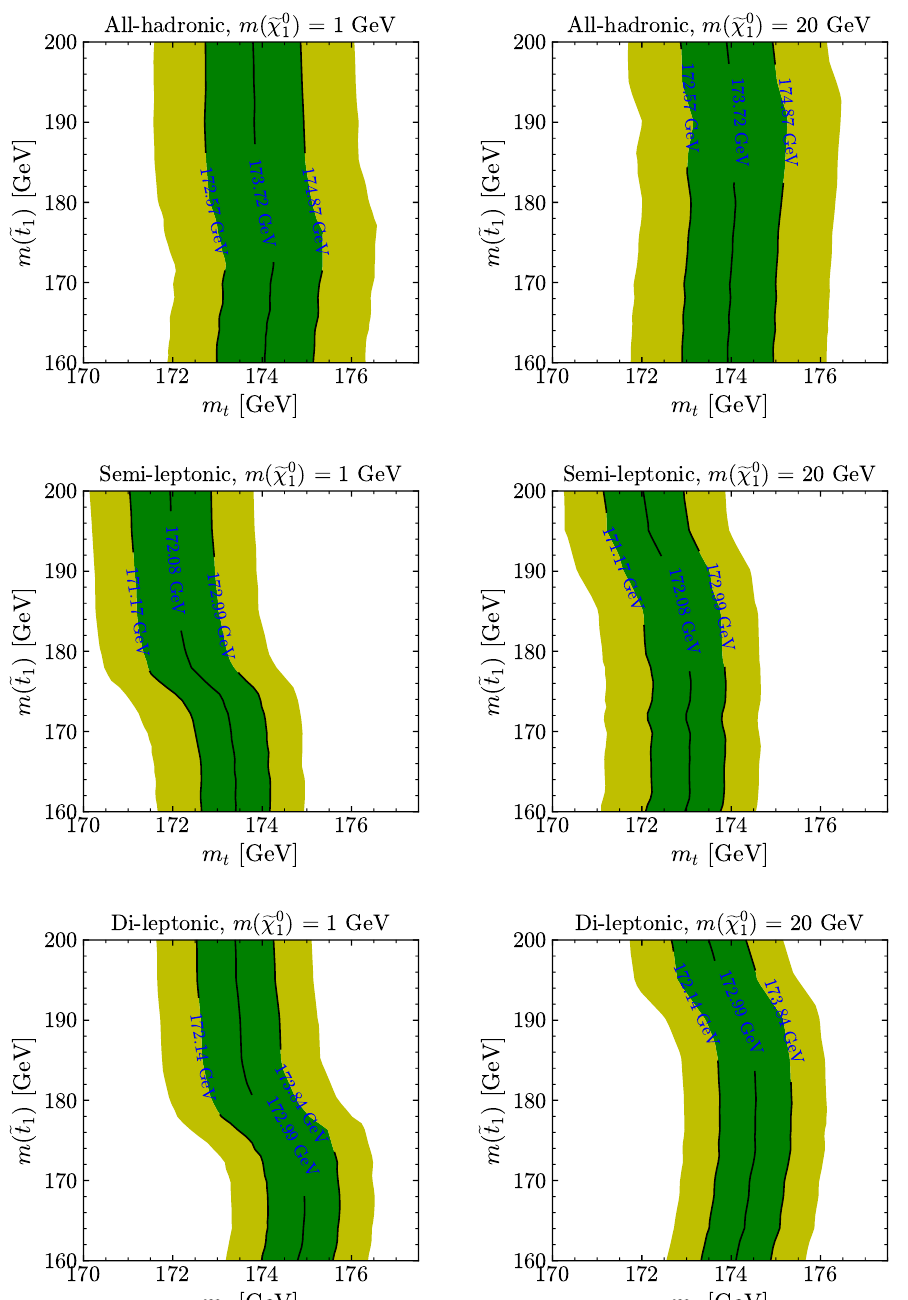
Figure 11 . Contours of the mass extracted when using templates constructed in the SM only assumption. The top, middle, and bottom rows correspond to the all-hadronic, semi-leptonic, and di-leptonic channels, respectively. The plots in the left column correspond to the choice m ( ~ (cid:31) 0 1 ) = 1 GeV, while those in the right column are for m ( ~ (cid:31) 0 1 ) = 20 GeV. In each panel, the central line denotes the value measured by ATLAS in the given channel. The green (yellow) band illustrates the regions in parameter space where the reconstructed mass is within 1- (cid:27) (2- (cid:27) ) of the measurement using the reported uncertainty.